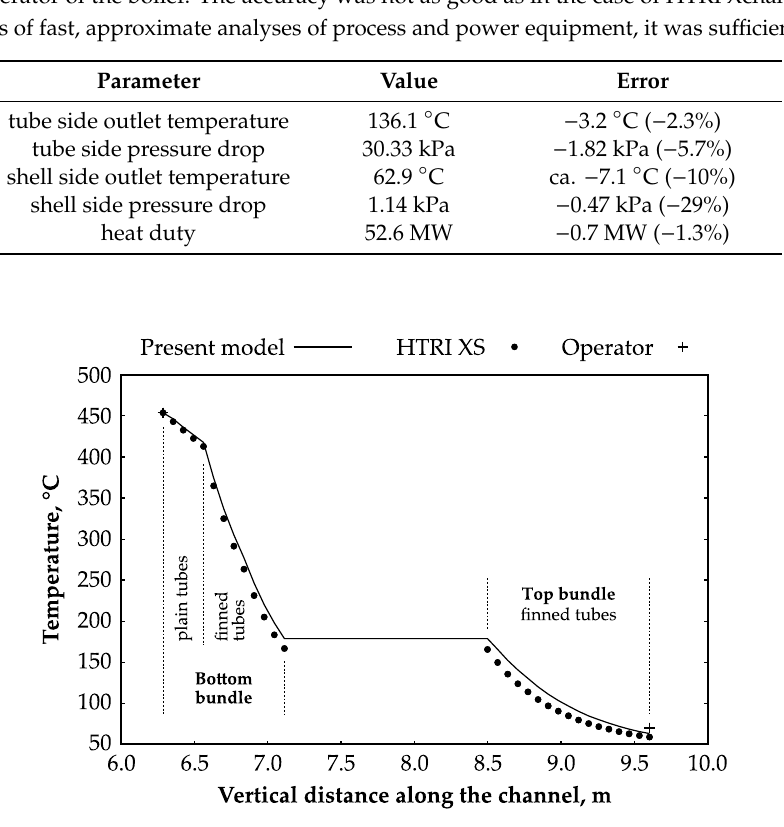
Figure 14. Visualization generated in Kitware ParaView of the bundles and the surrounding portion of the flue gas duct (front faces are culled). These were colored by the tube-side (water) and the shell-side (flue gas) temperatures obtained using the FEA-based model.